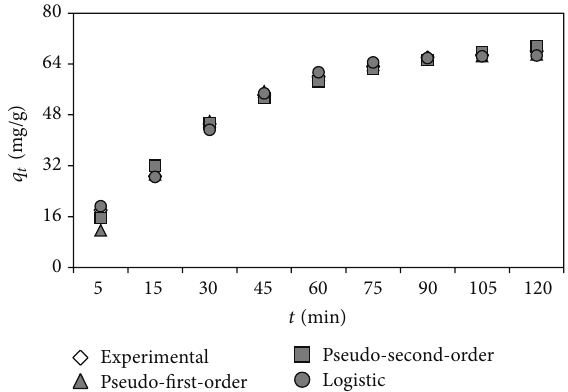
Figure 6: Comparison of kinetic models for biosorption